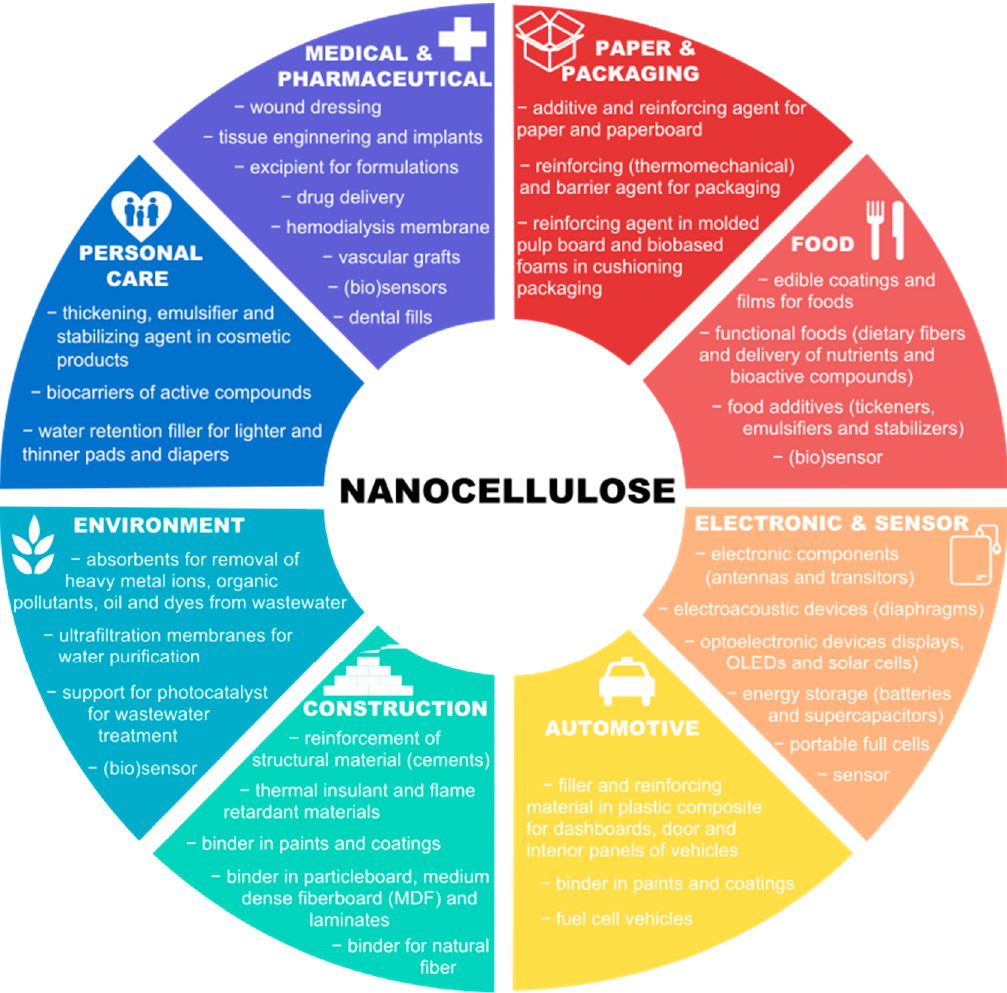
Figure 4. The potential application of nanocellulose in different fields.